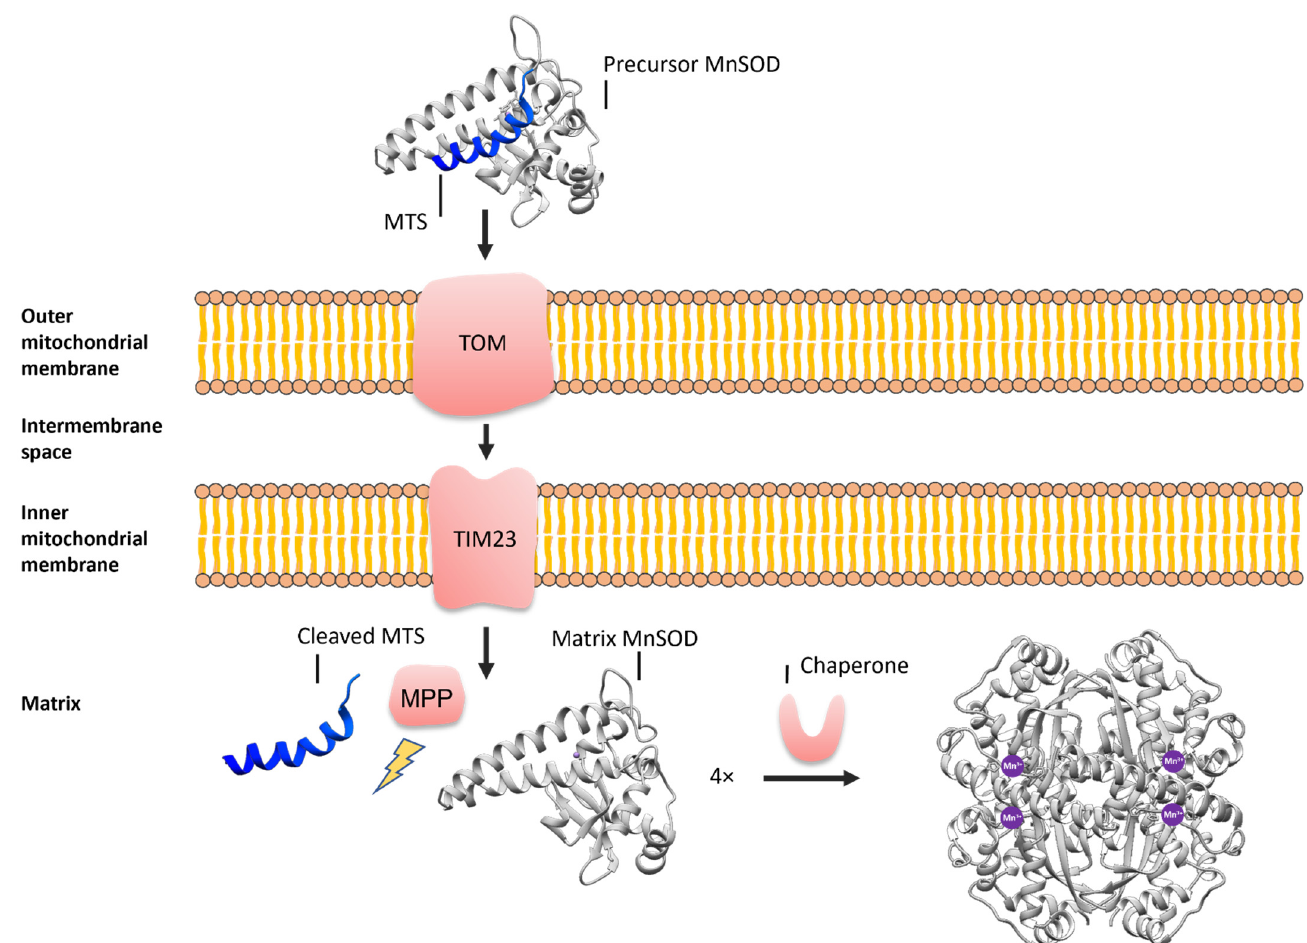
Figure 1. A schematic representation of the mitochondrial protein import. The precursor MnSOD reaches the outer mitochondrial membrane, where its MTS interacts with the TOM complex, which requires an amphiphilic α -helix. The TIM23 complex then transports the precursor MnSOD across the inner mitochondrial membrane into the mitochondrial matrix, where the MPP cleaves off the MTS. Chaperones then fold MnSOD into its active form and insert one Mn 3+ ion per